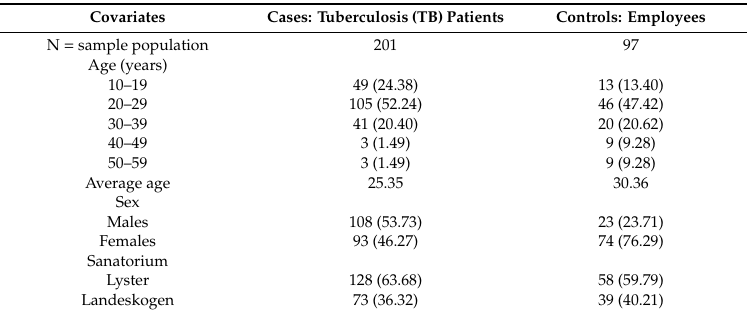
Table 1. Distribution of covariates by case-control status (N and